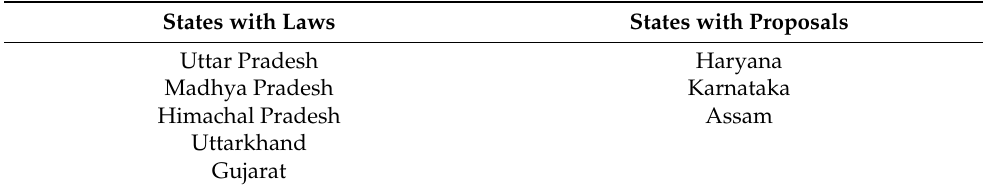
Table 1. States with Anti-Conversion Laws or Proposals. States with